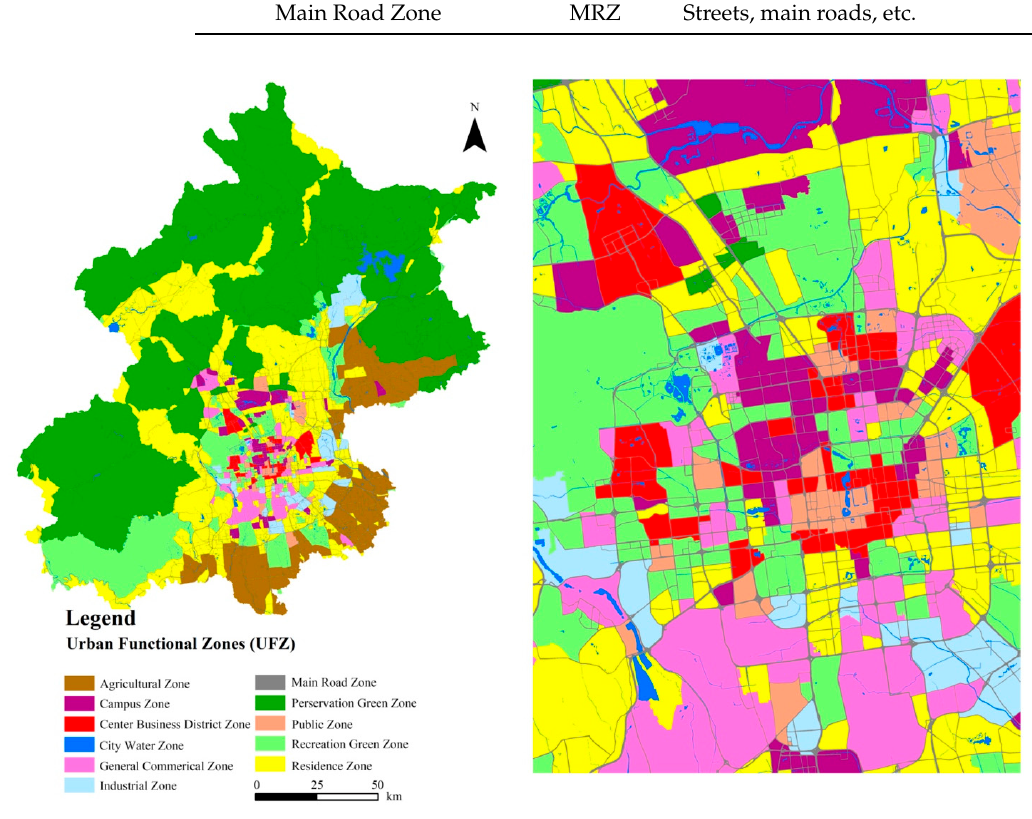
Figure 5. Urban functional zone ( left ) and an enlarged view inside the 5th ring-road of Beijing ( right ).